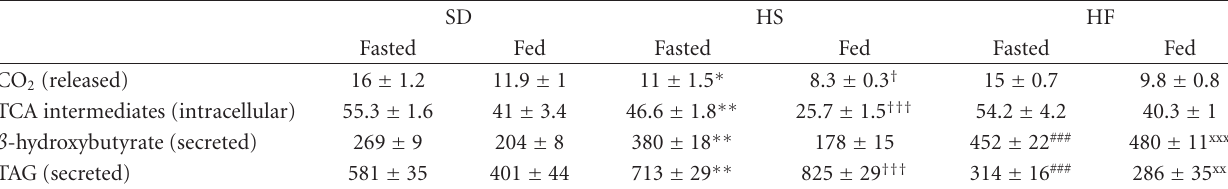
Table 3: The incorporation of intracellular TAG-derived 14 C palmitic acid into CO 2 , TCA intermediates, secreted β -hydroxybutyrate, and secreted triacylglycerols from liver slices in vitro .